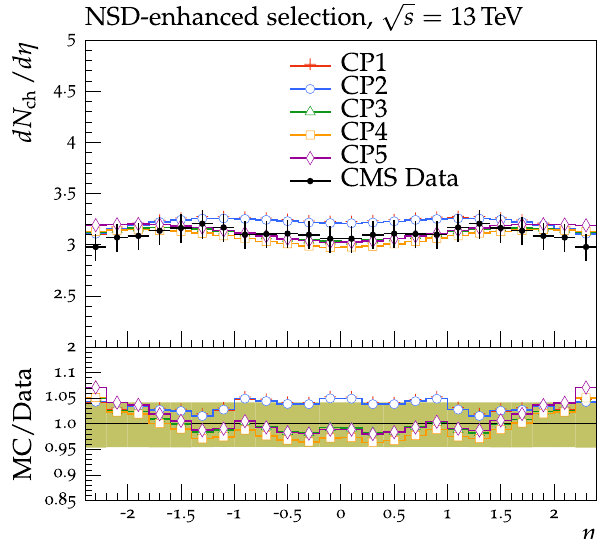
ratio of the simulations to the data (MC/Data) is also shown, where the shaded band indicates the total experimental uncertainty in the data. Vertical lines drawn on the data points refer to the total uncertainty in the data. Vertical lines drawn on the MC points refer to the statistical uncertainty in the predictions. Horizontal bars indicate the associated bin